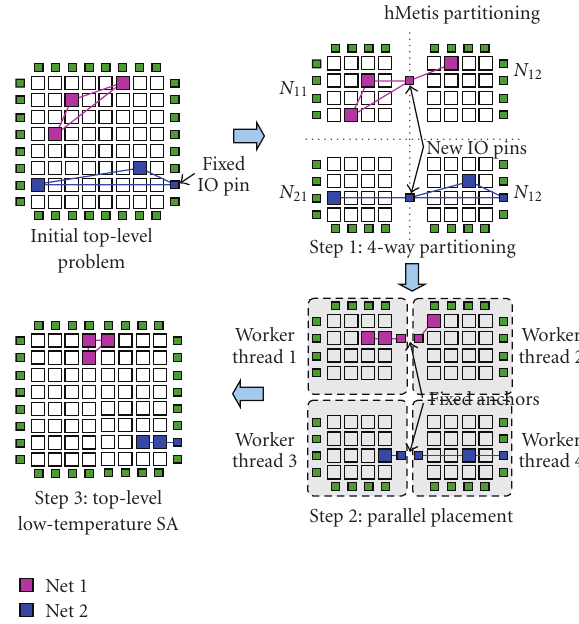
Figure 4: Subchip new IO pins are created during partitioning. They will act as fixed anchors during the parallel placement of all subchips.